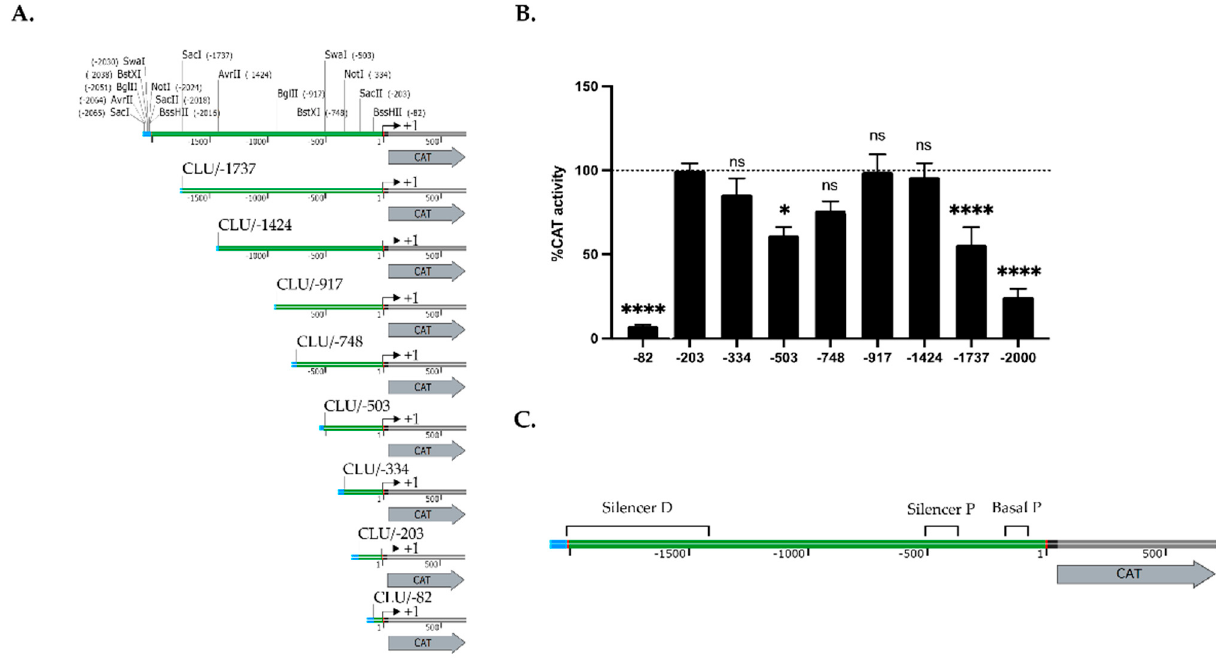
Figure 2. Transfection of the CLU gene promoter in human corneal epithelial cells. ( A ) Representation of the CLU/CAT recombinant plasmids used for transfection analyses. Numbers indicate the 5 ′ position relative to the CLU theoretical mRNA start site (indicated by a curved arrow). ( B ) CAT activities measured following transfection of the CLU/CAT constructs shown in panel ( A ) in human corneal epithelial cells. CAT activity is expressed relative to the level directed by CLU/-203 construct. Values considered to be statistically significant from those obtained with the CLU/-203 construct are indicated (* and ****: p values < 0.05 and < 0.0001, respectively). ns: Values considered to be statistically non-significant. ( C ) Schematic representation of the basal promoter (basal P) and both the proximal and distal silencers along the CLU promoter and 5 ′ -flanking sequence, based on the transfection results from the panel ( B ).